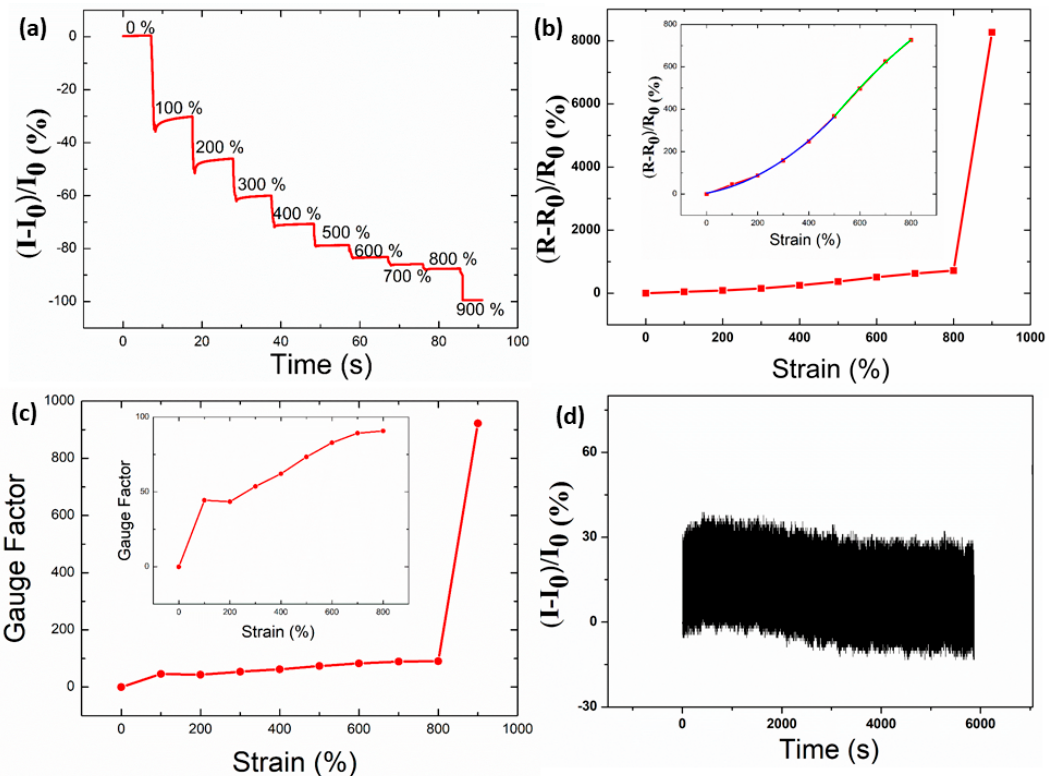
Figure 4. ( a ) Current responses of the sensor under di ff erent strains. ( b ) Typical relative resistance-strain curve of the strain sensor with a spring-like configuration. ( c ) The gauge factor-strain curve of the strain sensor with spring-like configuration. ( d ) Long-term stability test of a TPU / AgNWs strain sensor for 1000 stretching-releasing cycles from a 0% to 100% strain.